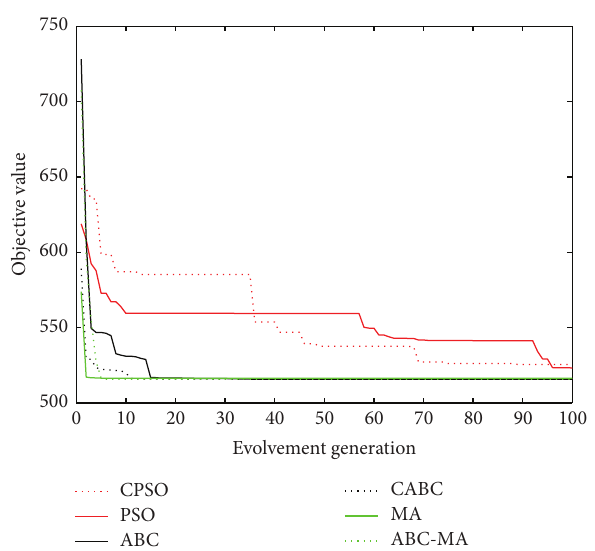
Figure 9: The convergence curve of the TAE